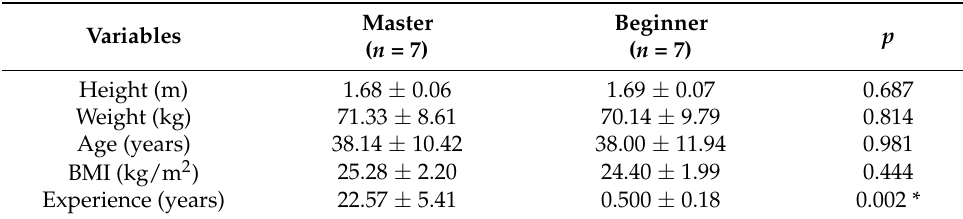
Table 1. Subjects’ basic information.